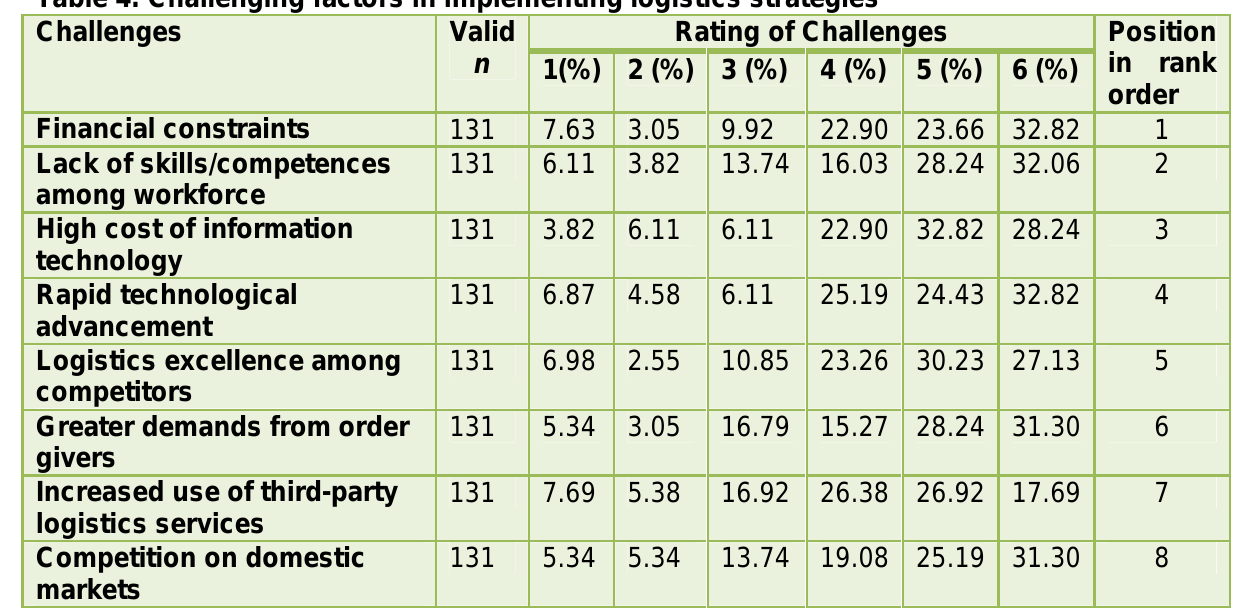
Table 4: Challenging factors in implementing logistics